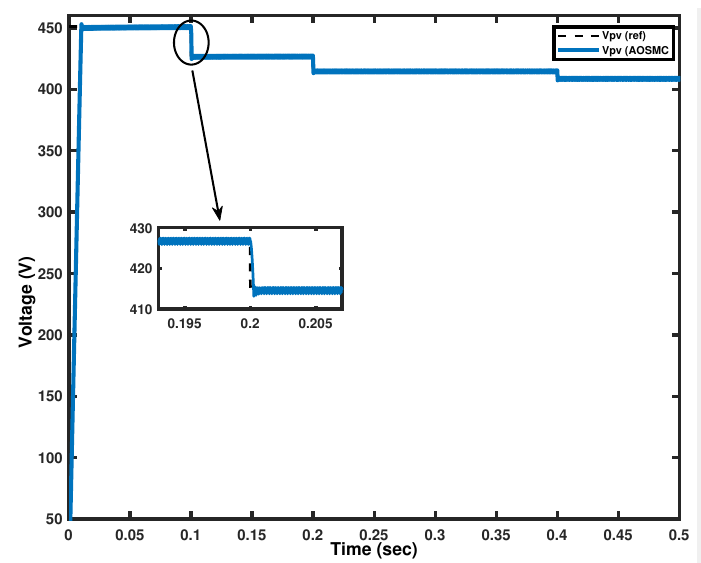
Figure 12. Tracking the PV voltage under varying irradiance.